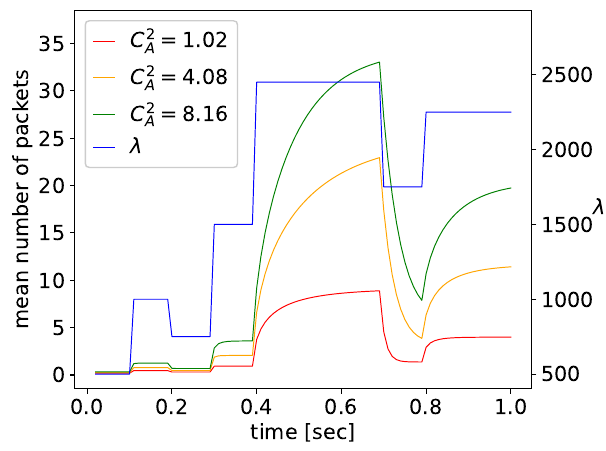
Figure 7. Mean queue for different C 2